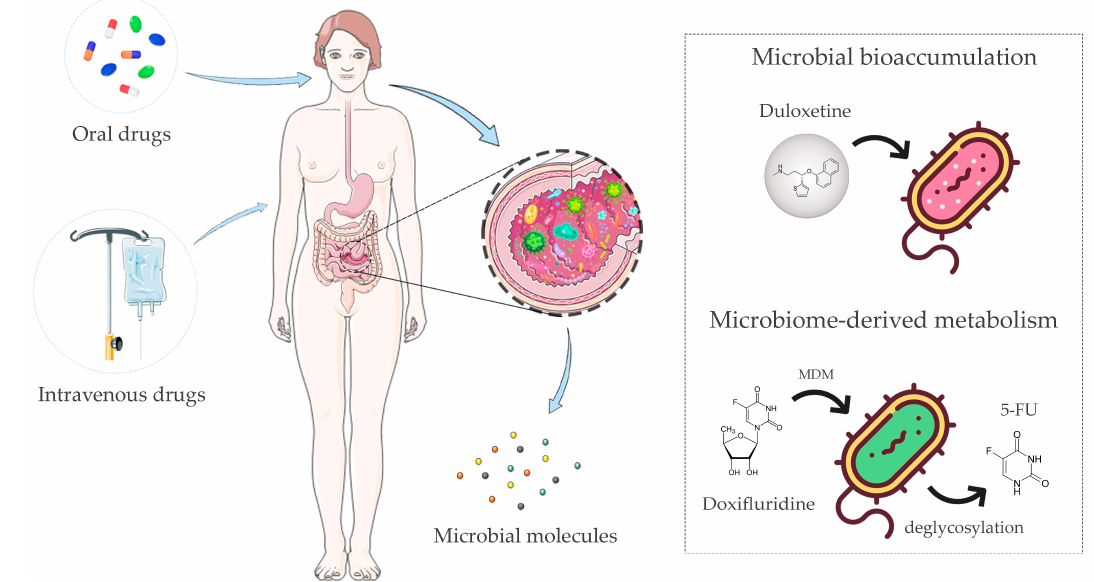
Figure 1. The gut microbiota is able to directly or indirectly interact with drugs, influencing the therapeutic outcome. The gut microbiota has been shown to influence the absorption, distribution, metabolism, excretion, and toxicity profiles of enterally or parenterally administered drugs. These microbiota–drug interactions may result in more or less active/toxic drug metabolites, with a variable impact on the host’s physiology. Microbial bioaccumulation and microbiome-derived metabolism (MDM) are the two main mechanisms involved. Bioaccumulation of duloxetine and MDM of doxifluridine to 5-fluorouracil (5-FU) are shown as examples of these phenomena. The figure was partly generated using Servier Medical Art, provided by Servier, licensed under a Creative Commons Attribution 3.0 unported license and images designed by